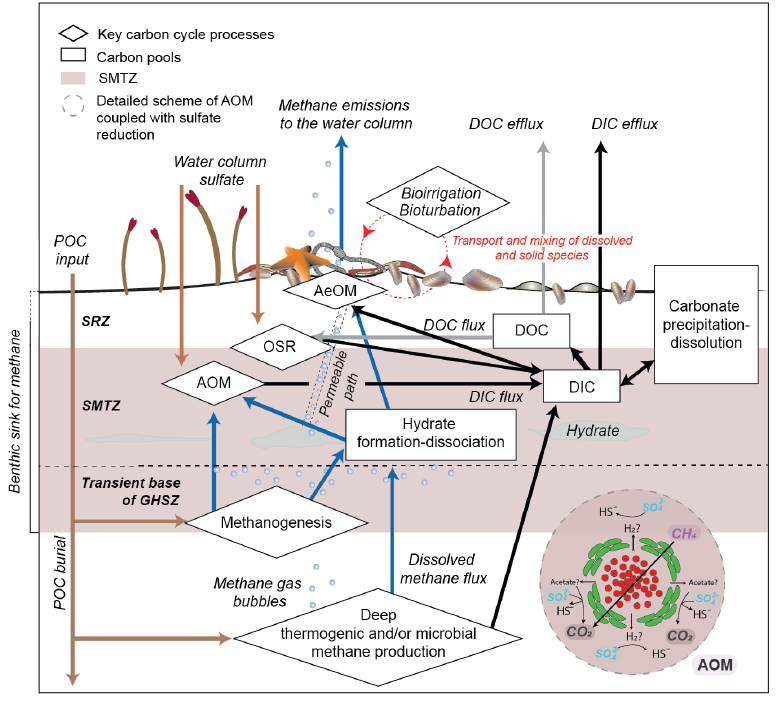
Figure 5. Conceptual representation of the main carbon cycle processes and carbon pools charac- terising marine sediments. Note that AeOM only contributes to the benthic sink when oxygen is available within the mixed sediment layer (zone indicated by the dashed line on the left side of the figure). Arrows indicate how the different processes are connected. Within the inset of the AOM process, question marks refer to the dependence of hydrogen ( H 2 ) and acetate availability on the en- vironmental conditions. POC: particulate organic carbon; SRZ: sulfate reduction zone; SMTZ: sulfate methane transition zone; GHSZ: gas hydrate stability zone; AeOM: Aerobic oxidation of methane; OSR: organoclastic sulfate reduction; AOM: Anaerobic oxidation of methane; DOC: dissolved organic carbon; DIC: dissolved inorganic carbon. Adapted from